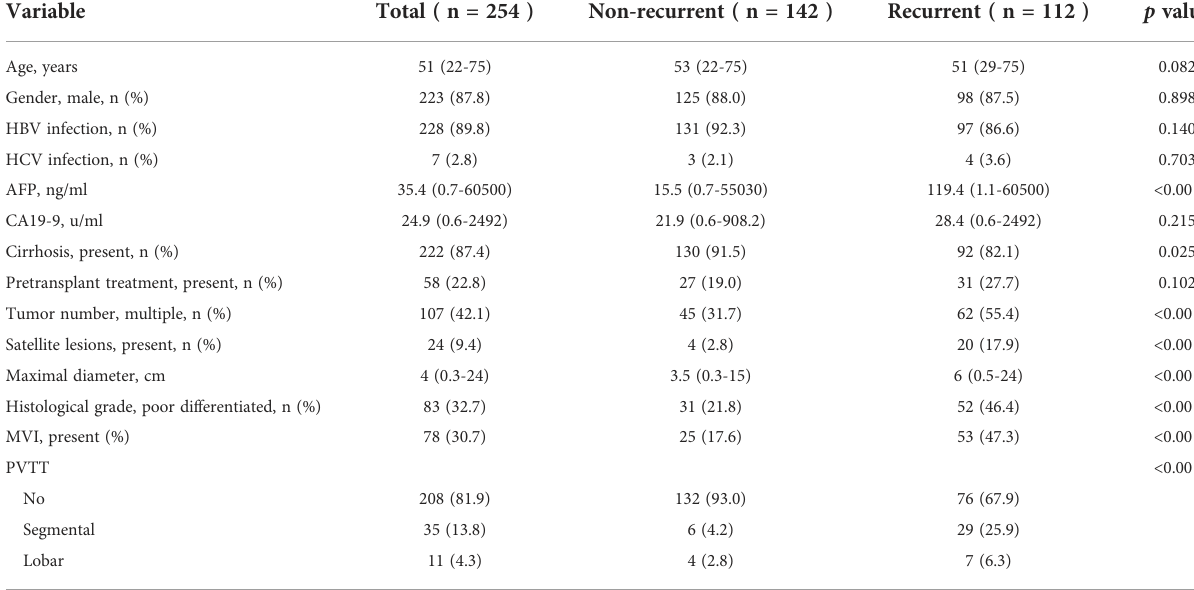
TABLE 1 Characteristics of patients receiving LT with HCC by recurrence